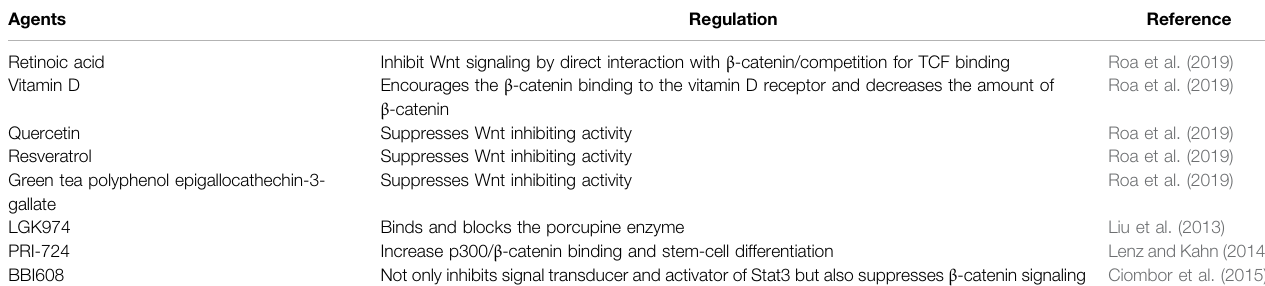
TABLE 2 | Some agents target Wnt/ β -catenin pathway in colon cancer.